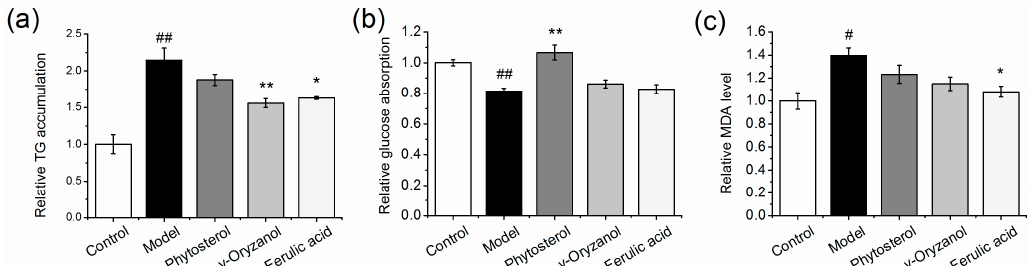
Figure 1. Relative TG accumulation ( a ), glucose absorption ( b ) and malondialdehyde level ( c ) in HepG2 cells. HepG2 cells were treated with an induction medium (10 mM glucose, 15 mM fructose and 1 mM FFA) for 24 h with or without functional components (100 µ M). 1% BSA in incomplete DMEM was selected as control. Data are presented as mean ± SEM ( n = 6). # p < 0.05 vs. control. ## p < 0.01 vs. control. * p < 0.05 vs. model. ** p < 0.01 vs. model.